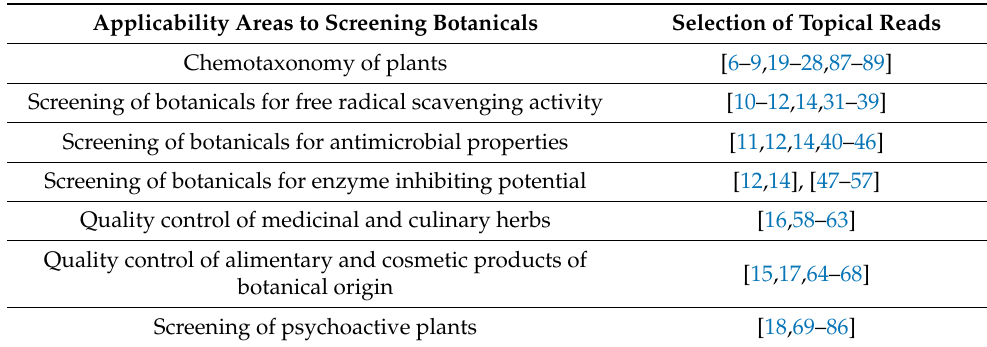
Table 1. Scoping review of references on thin-layer chromatography (TLC) in screening of botanicals. Applicability Areas to Screening Botanicals Selection of Topical Reads Chemotaxonomy of plants Screening of botanicals for free radical scavenging activity Screening of botanicals for antimicrobial properties Screening of botanicals for enzyme inhibiting potential Quality control of medicinal and culinary